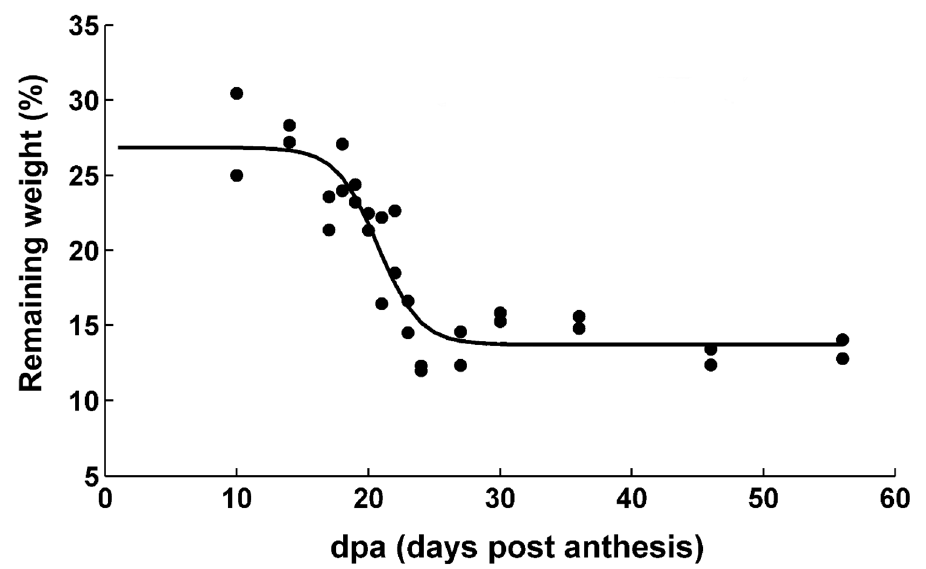
Figure 14. Evolution of the remaining weight percent at 600 °C as a function of dpa for TM-1 genotype.